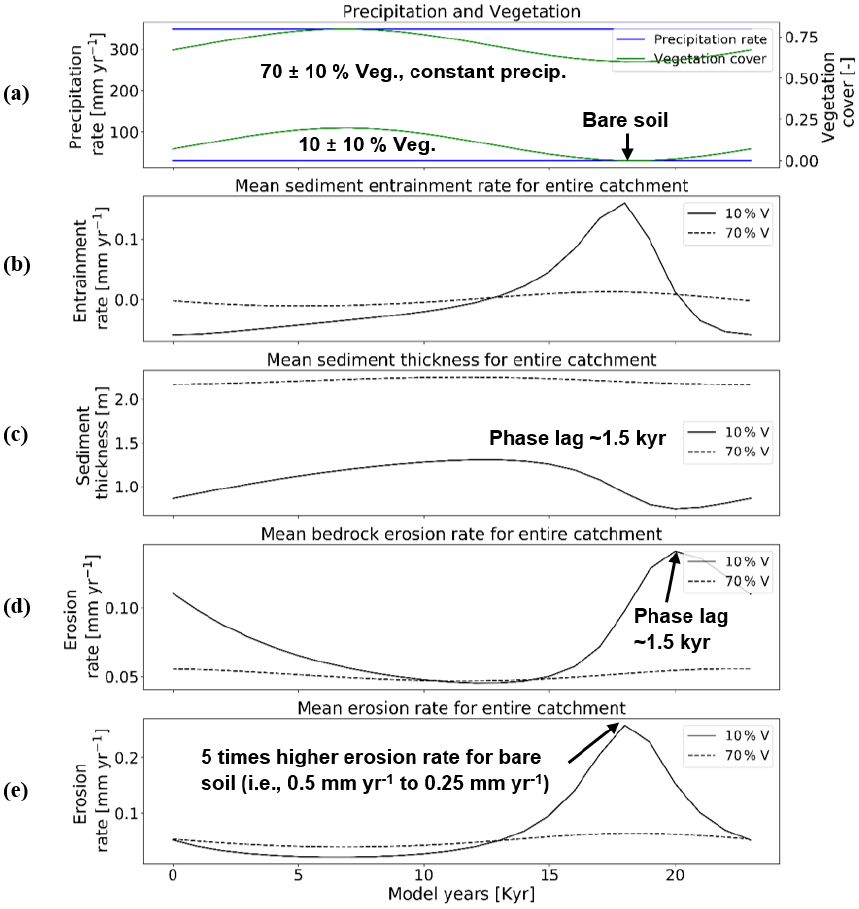
Figure 6. Temporal evolution of catchment-averaged predictions for scenario 2 described in the text (Sect. 3.2). Graphical representation of mean catchment sedimentation and erosion to (a) constant precipitation [mmyr − 1 ] and oscillating vegetation cover [–] in terms of (b) sed- iment entrainment [mmyr − 1 ], (c) sediment thickness [m], (d) bedrock erosion [mmyr − 1 ], and (e) mean erosion rates [mmyr − 1 ] for the entire catchment. The periodicity of climate and vegetation oscillations is 23kyr with a rock uplift rate of 0.5mmyr − 1